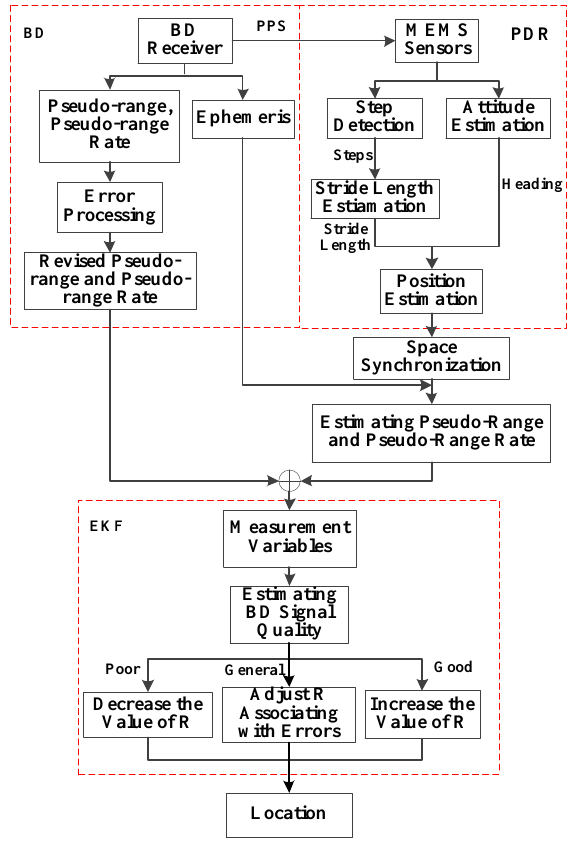
Figure 1. Architecture of the proposed